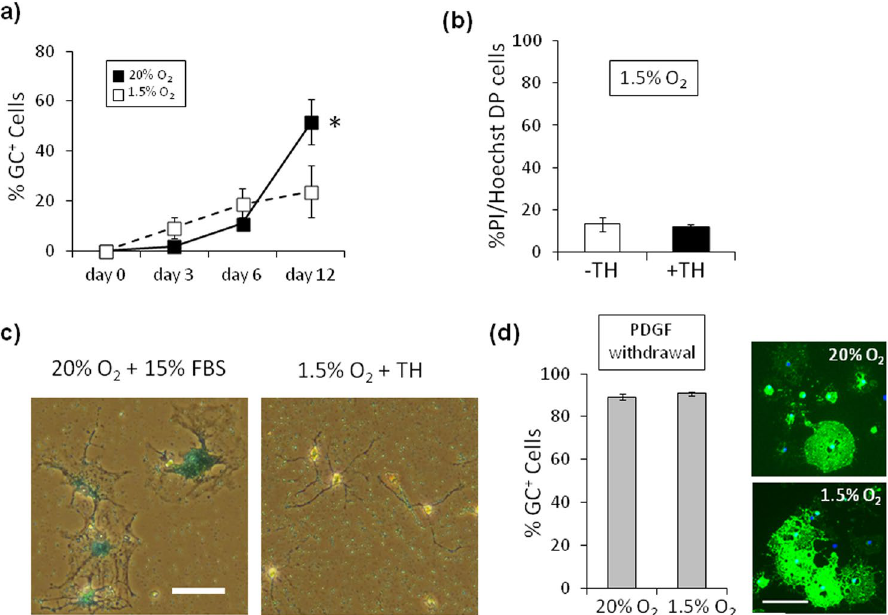
Figure 2. Hypoxia does neither induce cell death and replicative senescence, nor inhibit OL differentiation. ( a ) P7 OPCs cultured in PDGF and TH, in either 20% O 2 ( closed squares ) or 1.5% ( open squares ), were stained for GC after 3, 6 and 12 days, and the % of GC + cells were counted at each time point. * P < 0.05 (unpaired Student’s t -test, n = 3). ( b ) P7 OPCs were cultured in PDGF, without TH (-TH, white bar ) or with TH ( + TH, black bar ), in 1.5% O 2 for 15 days, and the percentage of dead cells (PI + , Hoechst 33342 + double positive cells) was determined (n = 3). ( c ) P7 OPCs were cultured in PDGF and TH in 1.5% O 2 for 20 days and stained for SA- β Gal (left panel); as a positive control, P7 OPCs cultured in 15% FBS in 20% O 2 for 20 days to induce replicative senescence were also stained for SA- β Gal (right panel). Scale bar: 50 μ m. ( d ) Freshly purified P7 OPCs were cultured in the absence of PDGF for 3 days, in either 20% O 2 (upper right panel) or 1.5% O 2 (lower right panel), and were labeled with anti-GC antibody ( green ) and DAPI ( blue ). Scale bar: 100 μ m. Percentages of GC + cells in 20% O 2 culture and 1.5% O 2 culture are shown in the graph on the left (n = 3). Note that rat OL differentiation obeying withdrawal of PDGF is not inhibited in 1.5% O 2 , the extensions of GC + membrane-like structure around the cell body in 1.5% O 2 were comparable with those in 20% O 2